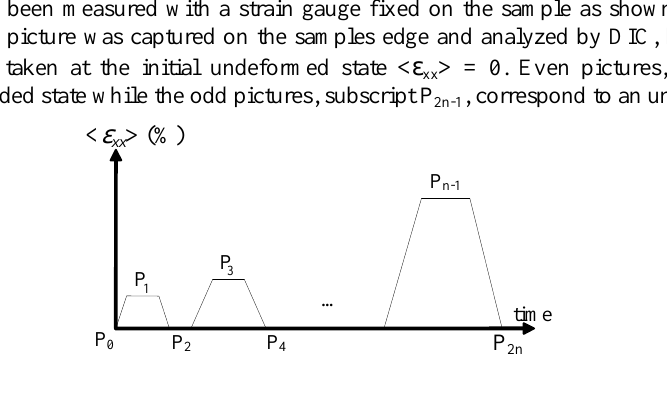
Fig. 3. Tensile test: loading / unloading